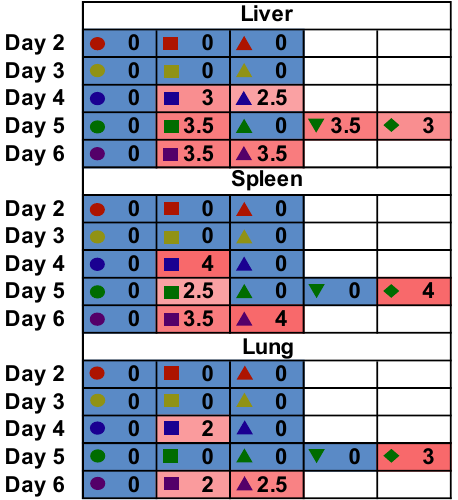
Figure 5. Histopathologic lesion inflammatory scores observed during the course of RVFV MP-12 infection in STAT2 KO hamsters. Lesions were scored as follows: 0, no lesions; 1, minimal; 2, mild; 3, moderate; 4, severe. The unique symbols correspond to values for the same animal on the specified day across all evaluated parameters shown in Figures 2–4. One animal in the day 6 p.i. group succumbed to infection prior to sacrifice and therefore is included in the day 5 p.i. group (green diamond).